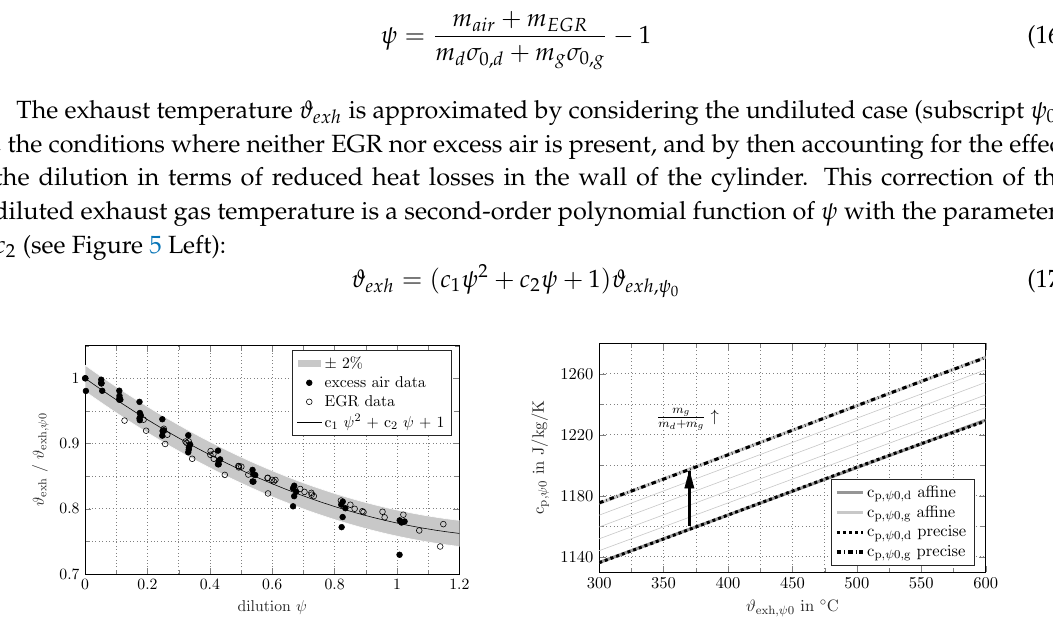
Figure 5. ( Left ) Effect of dilution ψ on the exhaust gas temperature ϑ exh normalized by the undiluted exhaust gas temperature ϑ exh , ψ 0 ; ( Right ) The undiluted exhaust gas has a heat capacity c p , ψ 0 that lies between the exhaust heat capacities of a diesel engine c p , ψ 0, d and that of a methane engine c p , ψ 0, g . The affine relations closely match the nonlinear, precise values given in